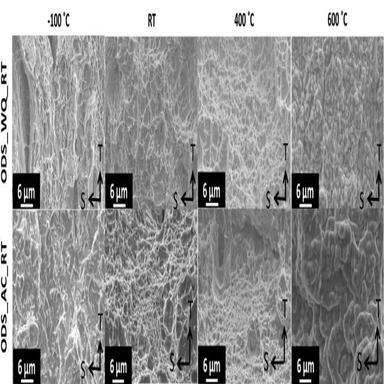
SEM SE images of fracture surfaces of ODS_WQ_RT and ODS_AC_RT at different temperatures